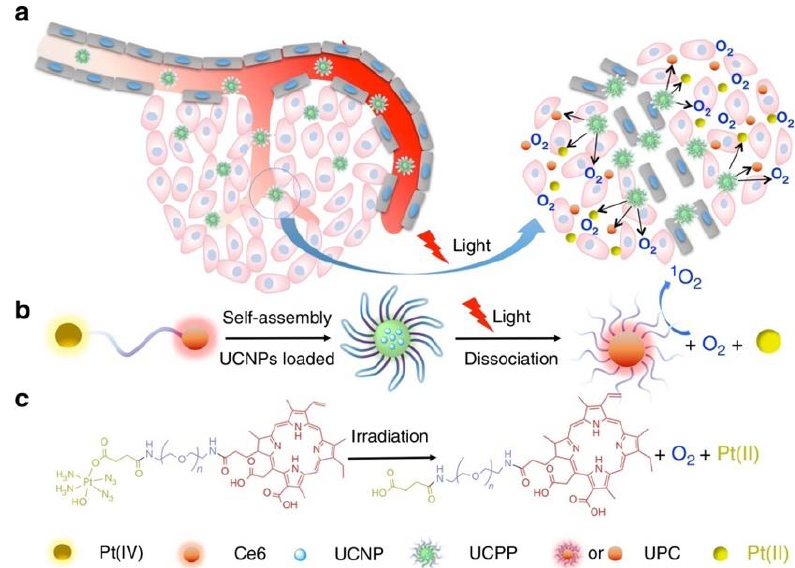
Scheme 5. Schematic representation of the mechanisms of action of UCNPs-embedded nanoparti- cles. The figure is reprinted from Xu et al. [108].